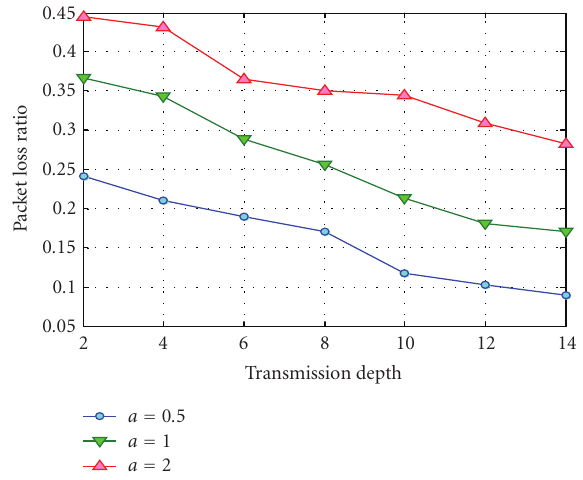
Figure 6: Packet loss ratio according to the transmission depth ( d ), for varying duration (indexed by a ) of bad state in a two-state Rayleigh channel.